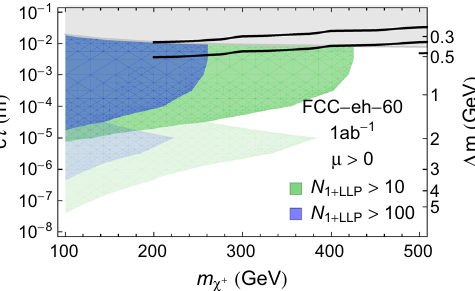
Fig. 12.3 Projected regions in the Higgsino parameter space where more than the indicated number of one (top) or two (bottom) LLPs are observed at the FCC-eh with a 60 GeV electron beam. Light shading indicates the uncertainty in the predicted number of events due to different hadronisation and LLP reconstruction assumptions. The green region represents the 2 σ sensitivity estimate in the presence of τ backgrounds. The black curves are projected bounds from disappearing track searches, for the HL-LHC (optimistic and pessimistic). Figure and analysis details are found in